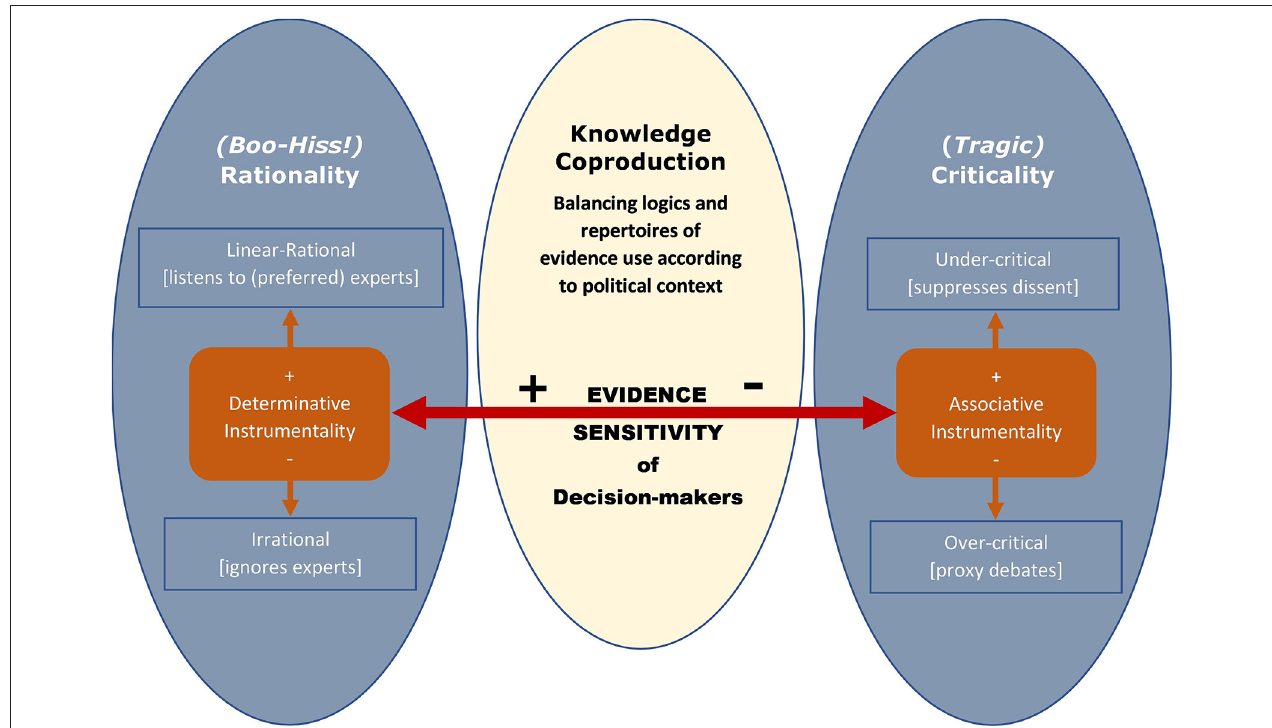
FIGURE 3 | A Critical Model of evidence use—Part 1: Rational vs. Critical orientations for evaluating evidence use. Political context determines the type and extent of evidence sensitivity, and thereby, knowledge instrumentality. Both aspirations for expert privilege and democratization must account for potential insensitivity of decision-making to